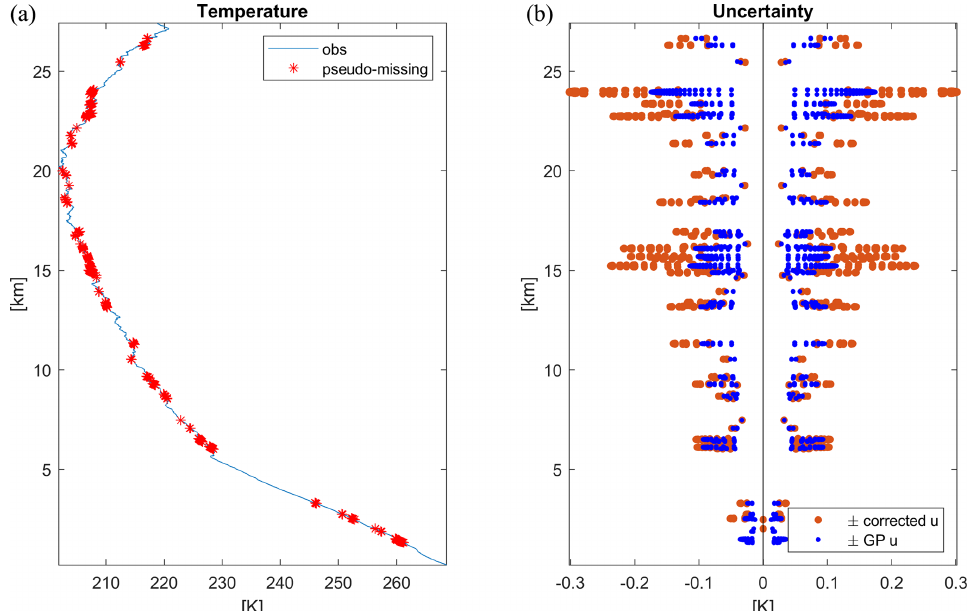
Figure 12. RS42 temperature profile at the Sodankylä site on 3 March 2017 12:00UTC. (a) Observation is in blue and block-bootstrap pseudo-missing are in red. (b) ± Linear interpolation uncertainty of pseudo-missing values; GP uncertainty (Eq. 8) is in dark blue; bootstrap uncertainty (Eq. 15) is in orange.